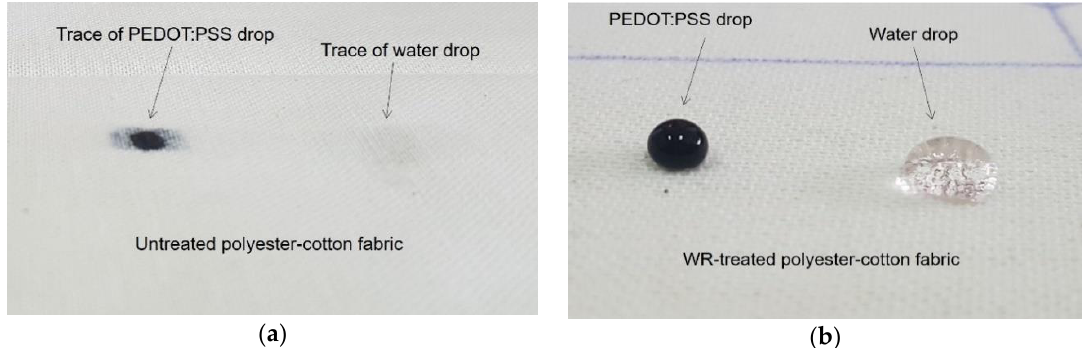
Figure 1. Drops of water and PEDOT:PSS polymer dispersion on ( a ) untreated fabric and ( b ) water repellent (WR)-treated fabric.